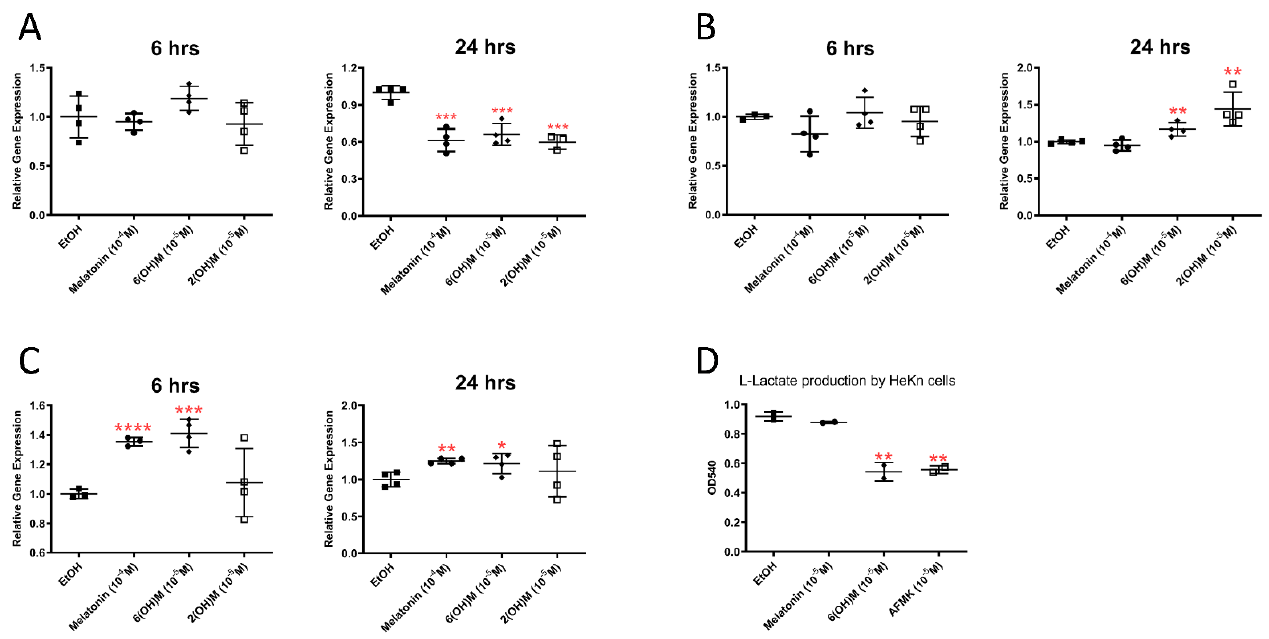
Figure 6. The effect of melatonin and its metabolites on the expressions of LDHA ( A ), PGC-1 ( B ) and SIRT-1 ( C ), and lactate production ( D ). Human epidermal (HaCaT) keratinocytes were cultured in presence of absence of the listed concentrations of the compounds and qPCR was performed as described in Materials and Methods with cyclophilin B as housekeeping gene. Each panel shows fold changes after calculated using delta-delta Ct normalized with housekeeping gene. Lactate accumulation in culture media is shown ( D ). The plots represent all values with calculated means and significance was evaluated both by Mann–Whitney U test and Student t -Test, which showed the same p values: * p < 0.05; ** p < 0.01; *** p < 0.001; **** p < 0.0001.